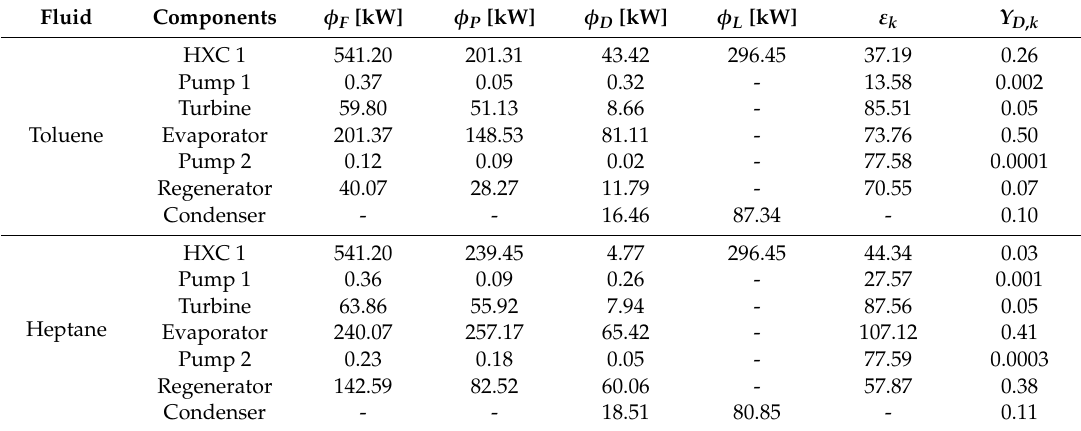
Table A2. Exergy analysis results for each component of the WHRS system based on RORC system using toluene and heptane. Fluid